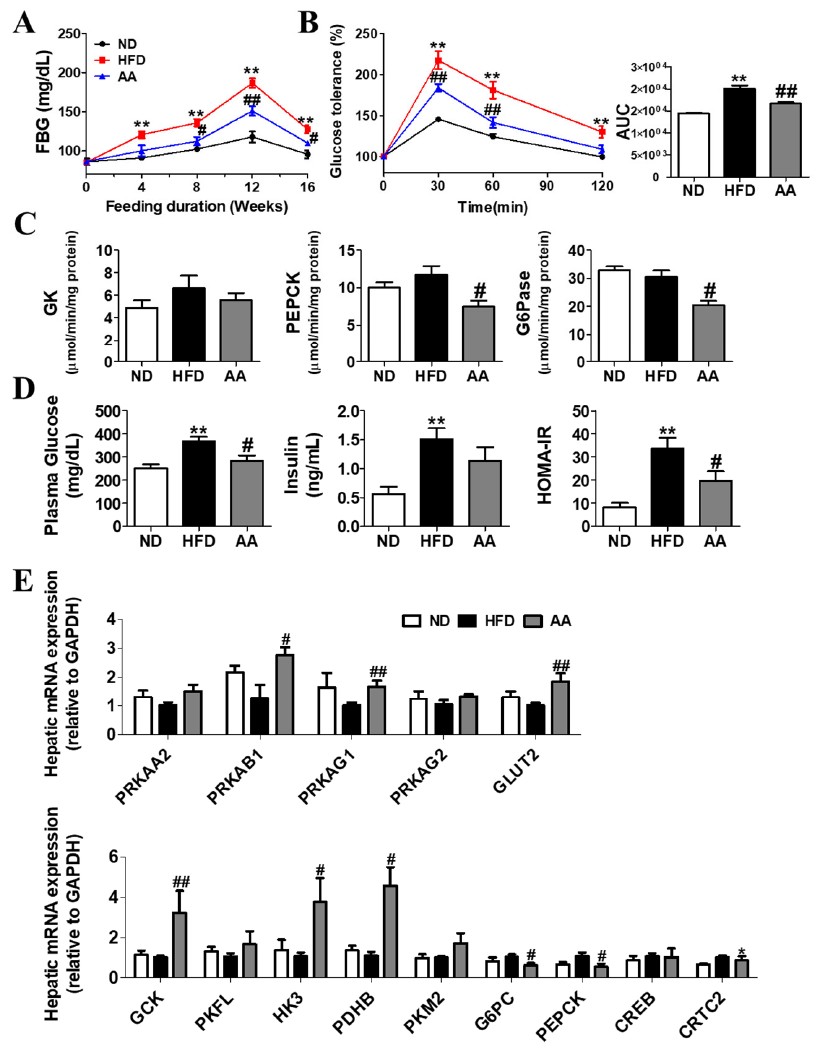
Figure 3. Effect of Artemisiae argyi water extract supplementation on diet-induced obesity. ( A ) Fasting blood glucose level; ( B ) intraperitoneal glucose tolerance test and area under the curve; ( C ) activities of hepatic enzymes related to glucose metabolism; ( D ) plasma glucose and insulin levels and